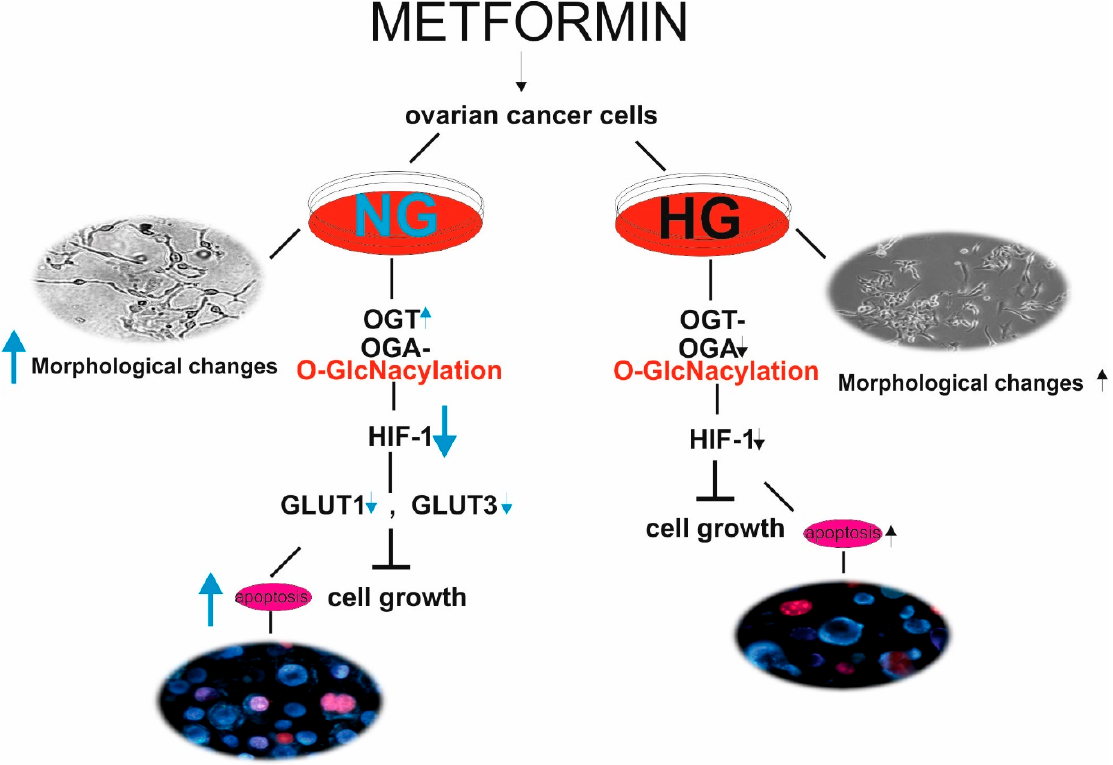
Figure 7. Metformin acts through a HIF1A/GLUT-dependent mechanism in SKOV-3 cells. The response of ovarian cancer cells to metformin depends on the level of glycemia, which affects diversely OGT and OGA expression and O-GlcNAcylation status. In NG, metformin increases the expression of OGT and downregulates HIF1A and GLUT expression leading to SKOV-3 cell apoptosis. HG dysregulates OGT and OGA expression and related HIF1A and GLUT expression preventing metformin-stimulated inhibition of growth and proliferation of SKOV-3 cells. Black arrows (HG conditions), blue arrows (NG conditions)—the height of arrow indicates intensification and direction of apoptotic changes, morphological changes and expression of the examined genes.